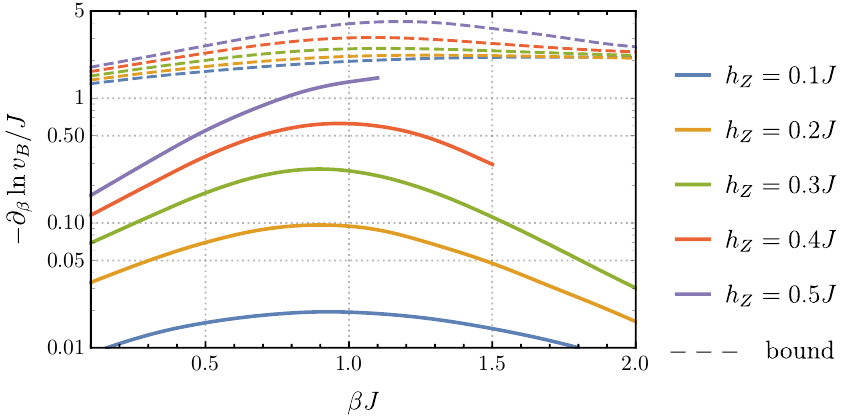
Figure 3: Bounding the temperature derivative of the butterfly velocity: Temper- = 1.05 J ature derivative of the butterfly velocity in mixed field Ising chains, with h X and different h in (21). The inverse temperature is denoted as β . The bound (23) is Z shown as the dashed curves. In the bound v is replaced by 3 Ja ( a = 1 is the lattice S ≤ v for v = 3 Ja and ξ = a in the Lieb-Robinson spacing), using the fact that v S LR inequality (5), in the spin duality frame. Curves are cut off when estimated error is significant (see the appendices for more